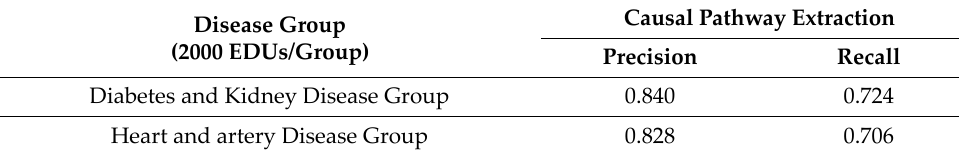
Table 4. The accuracy of extracting causal